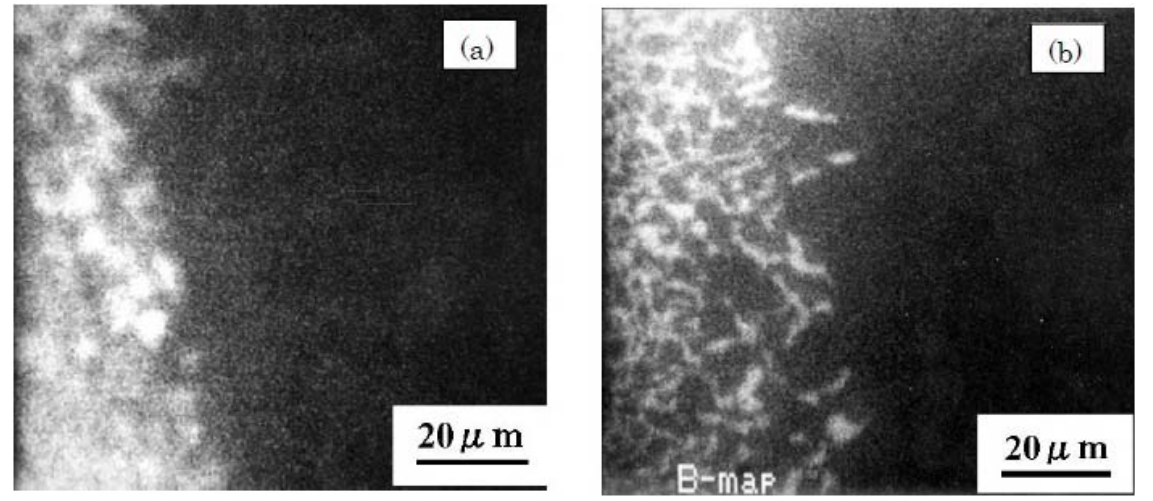
Figure 11. Auger electron spectroscopy maps of the distribution of boron in boronized non-superplastic SPDSS ( a ) and non-superplastic DSS ( b ) processed at 1273 K for 8 h [13].